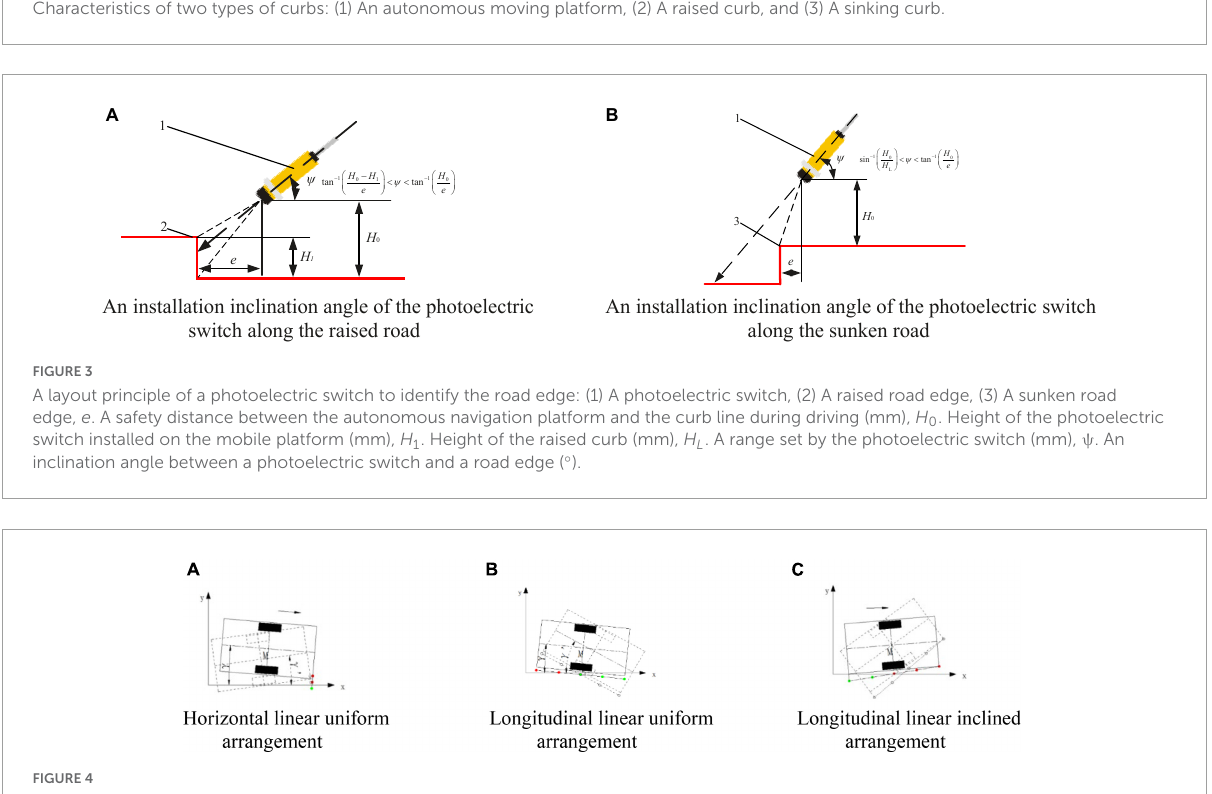
derive the heading angle ( γ ) of the mobile platform through a certain algorithm, so it is difficult to provide more complete and effective information for the curb line navigation control of the autonomous mobile platform. As shown in Figure 4B , the horizontal discrete distance of the mobile platform